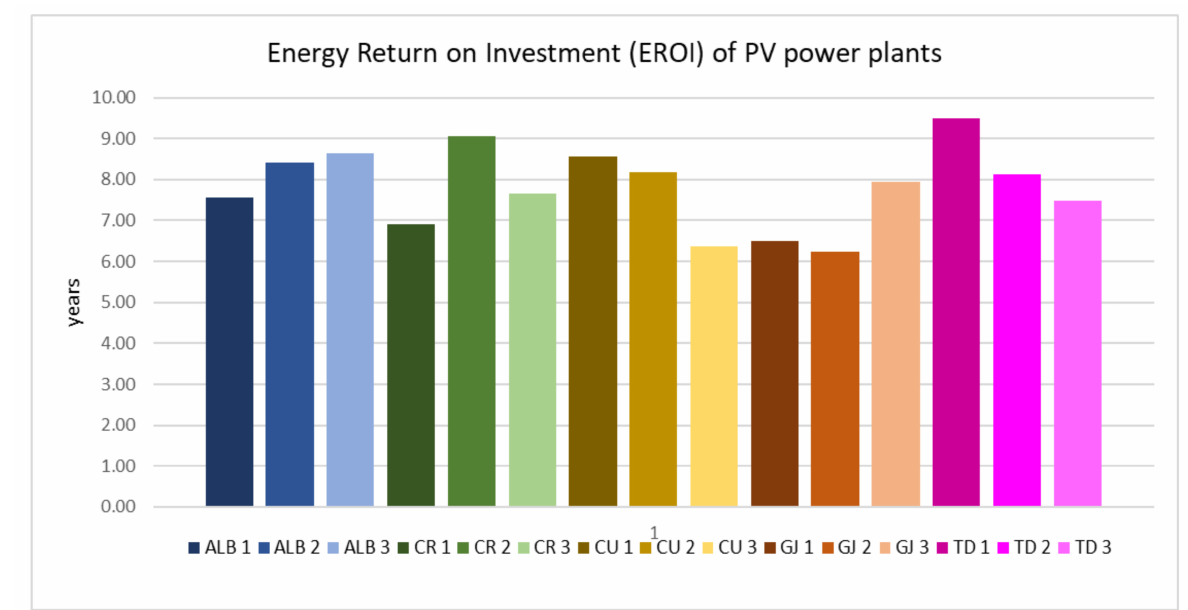
Figure 8. Representation of the calculated EROI values.